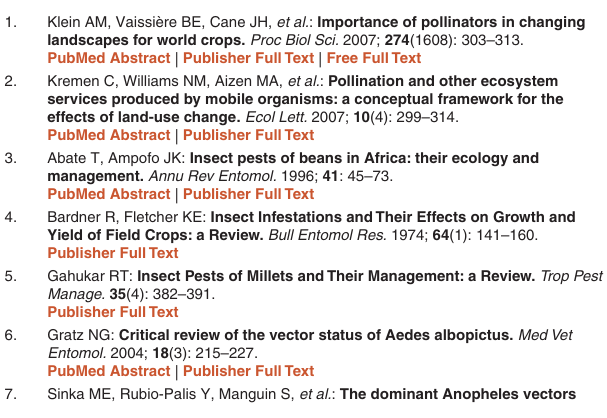
figshare: Inhibition of odorant and Orco agonist initiated current responses of oocytes expressing insect odorant receptors by various amines, doi: 10.6084/m9.figshare.977791